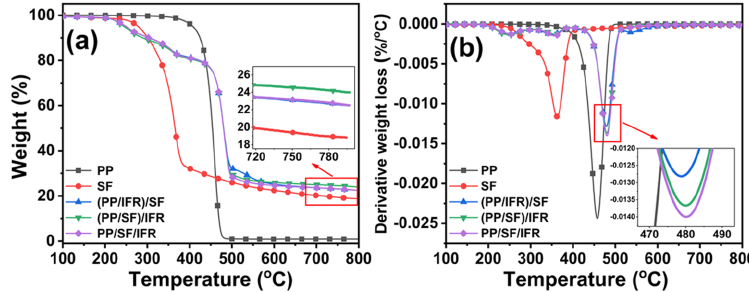
Figure 6. TGA ( a ) and DTG ( b ) of PP, SF, and PP/SF flame − retardant composites. Table 3. Thermal analysis data of PP/SF flame-retardant composites.